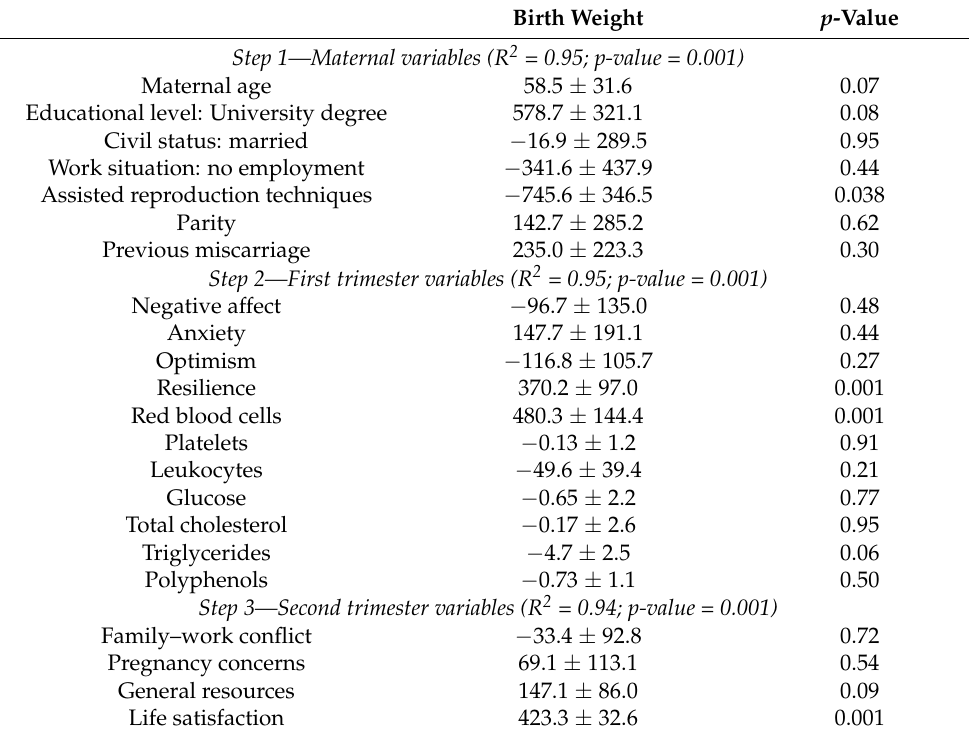
Table 2. Lineal regression analysis for birth weight as a dependent